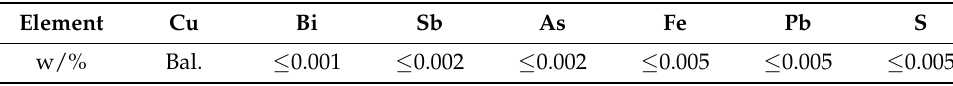
Figure 3. Experimental core-containing copper tube electrode. Table 2. Elemental constituents of copper tube.